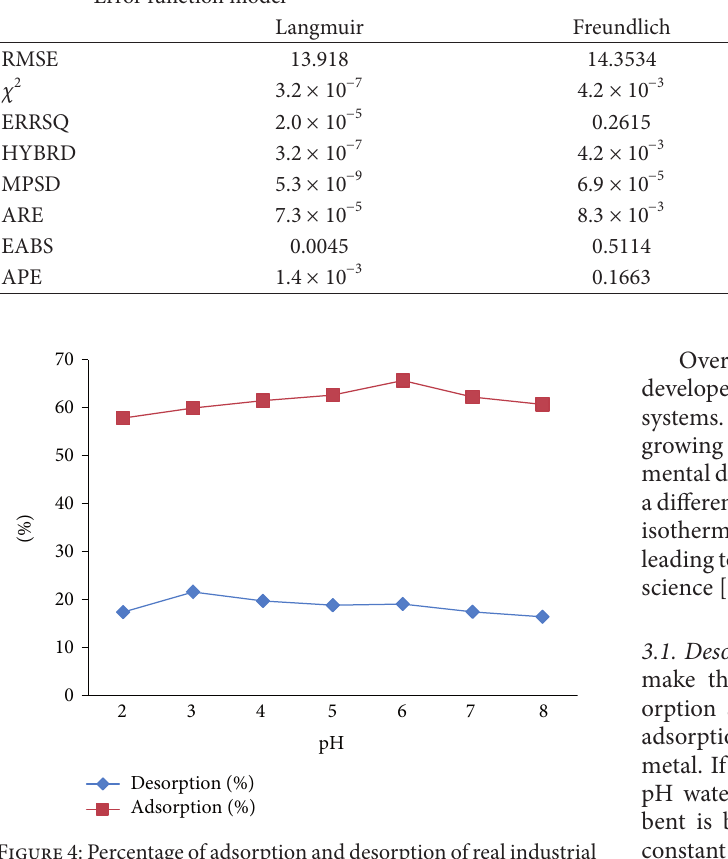
F 4: Percentage of adsorption and desorption of real industrial waste water onto